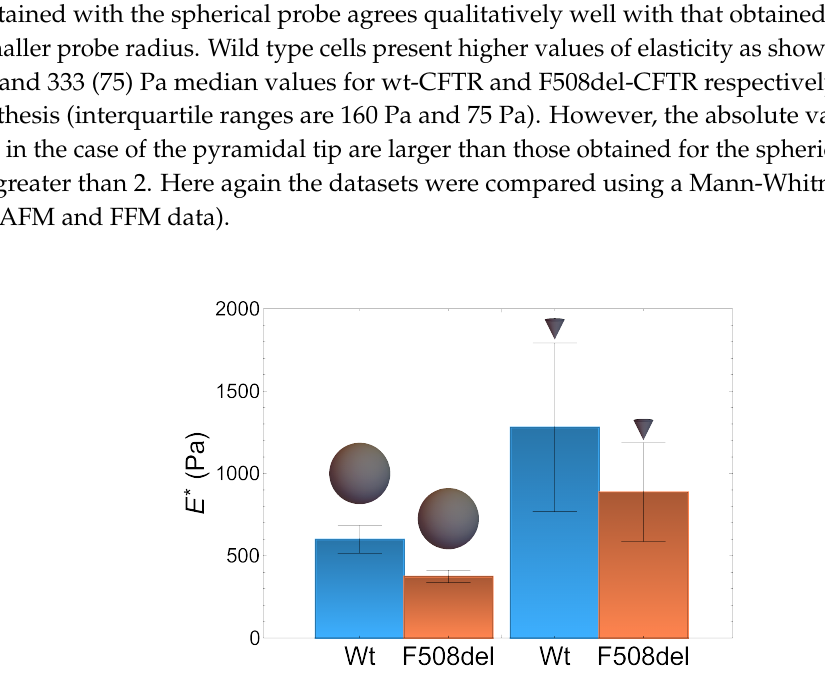
Figure 2. Atomic force microscopy analysis of wt-CFTR and F508del-CFTR cells obtained with Force Feedback Microscopy (FFM) using a spherical 1 µ m radius bead and with an Atomic Force Microscopy (AFM) and a pyramidal